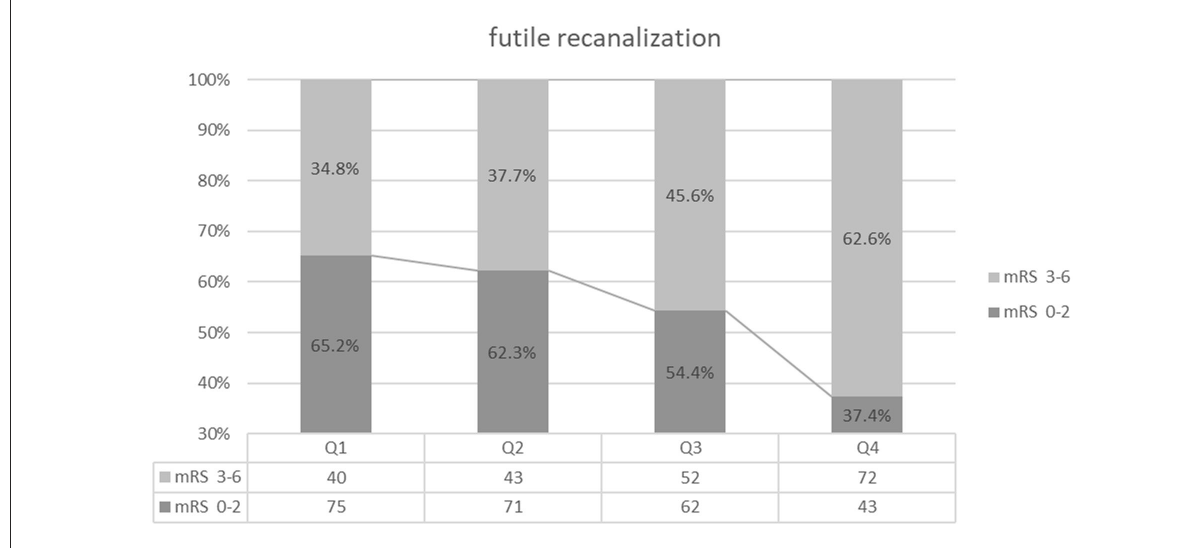
FIGURE2 Futile recanalization comparison among the quartile groups.